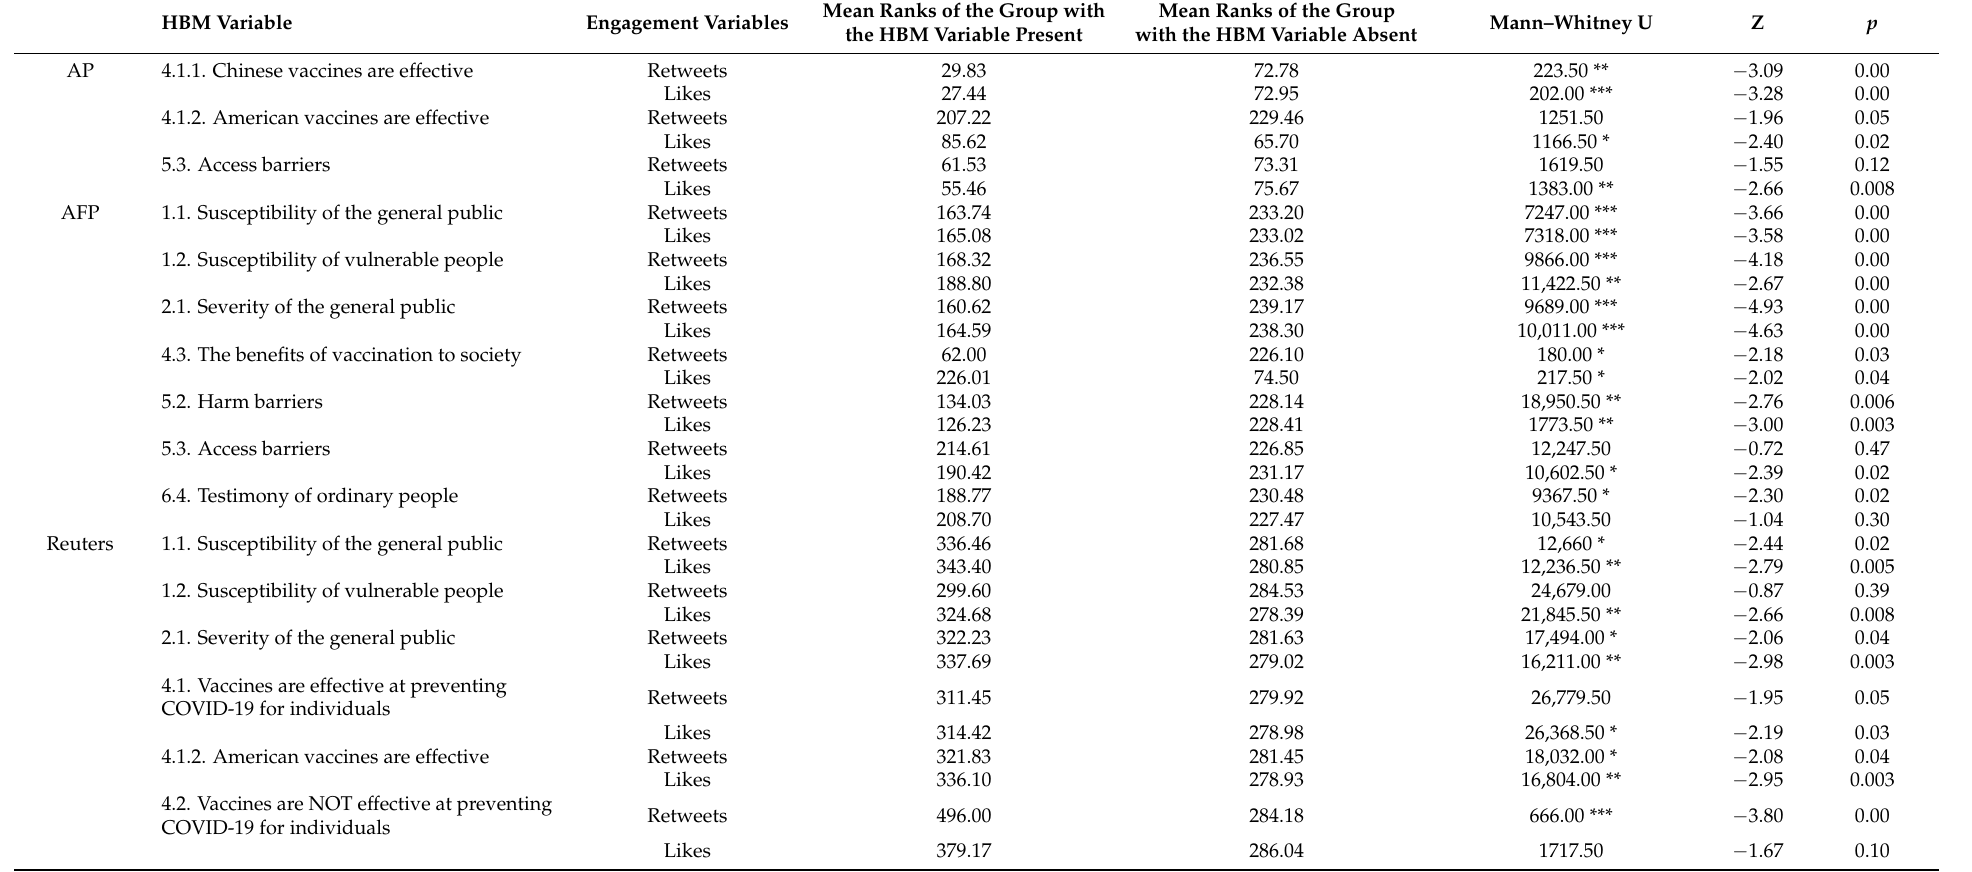
Table 6. Sub-themes and Twitter